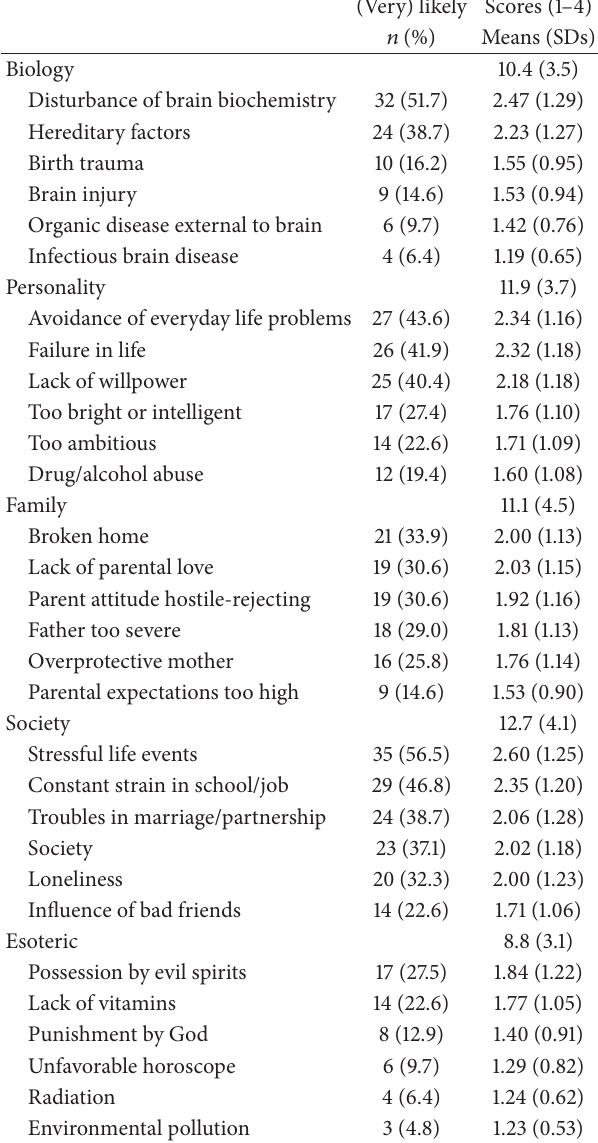
Table 1: Causes of illness (Angermeyer and Klusmann Scale) as identified by patients ( 𝑁 =